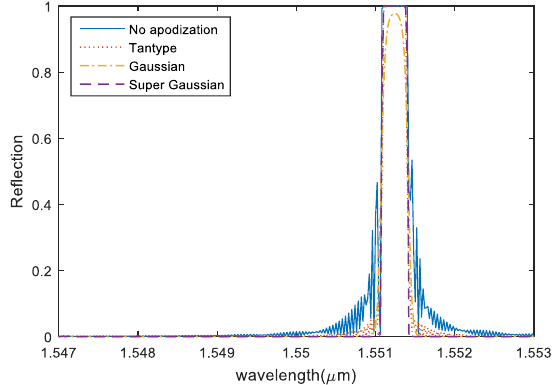
Figure 6: Reflection response of FBG with three different apodization under 1000 micro strain.